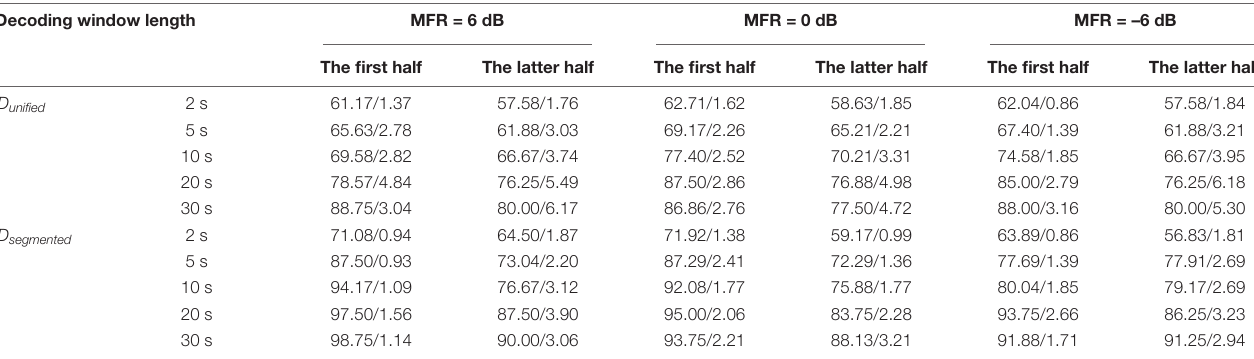
TABLE 1 | The averaged AAD accuracies and the standard deviations (mean/standard deviation) decoded by D unified and D segmented using different decoding window length (i.e., 2, 5, 10, 20, and 30 s) before and after the switching of attention from the male to the female speaker streams under the 6–, 0–, and –6-dB MFR conditions. Decoding window